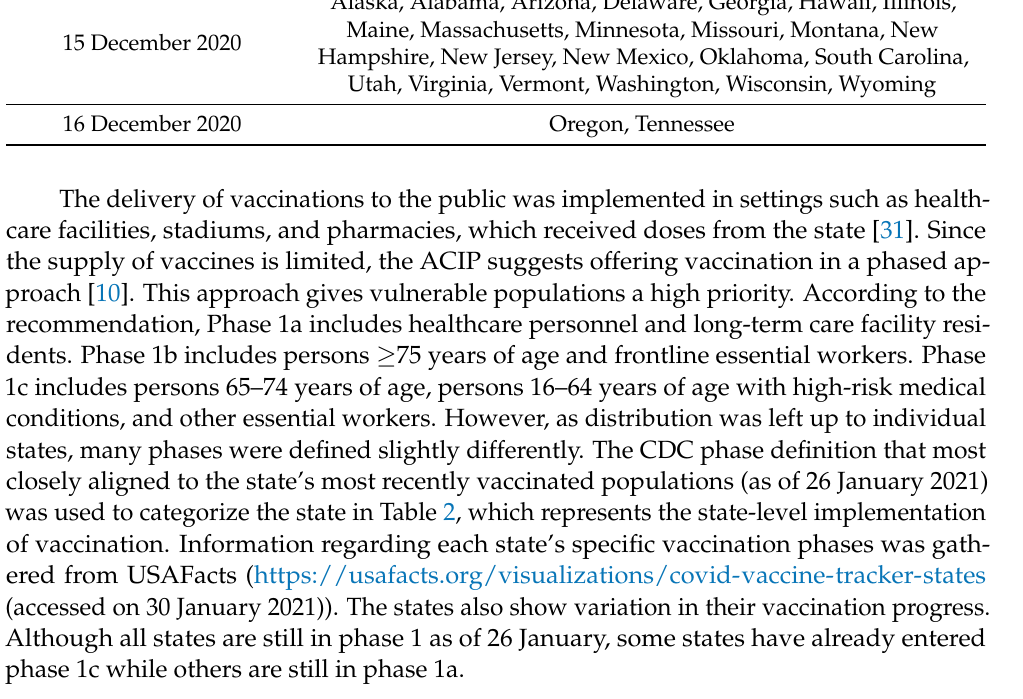
Table 2. The implementation status of COVID-19 vaccination in every state (as of 26 January 2021).